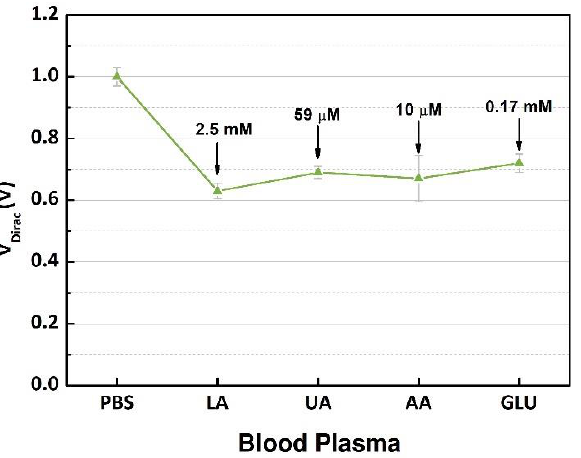
Figure 8. Measurement of the Dirac point voltages (n = 3) of PBS, plasma sample containing 7.5 mM of L-lactic acid (LA), and after injection of each interference biochemical (uric acid (UA), ascorbic acid (AA), and glucose